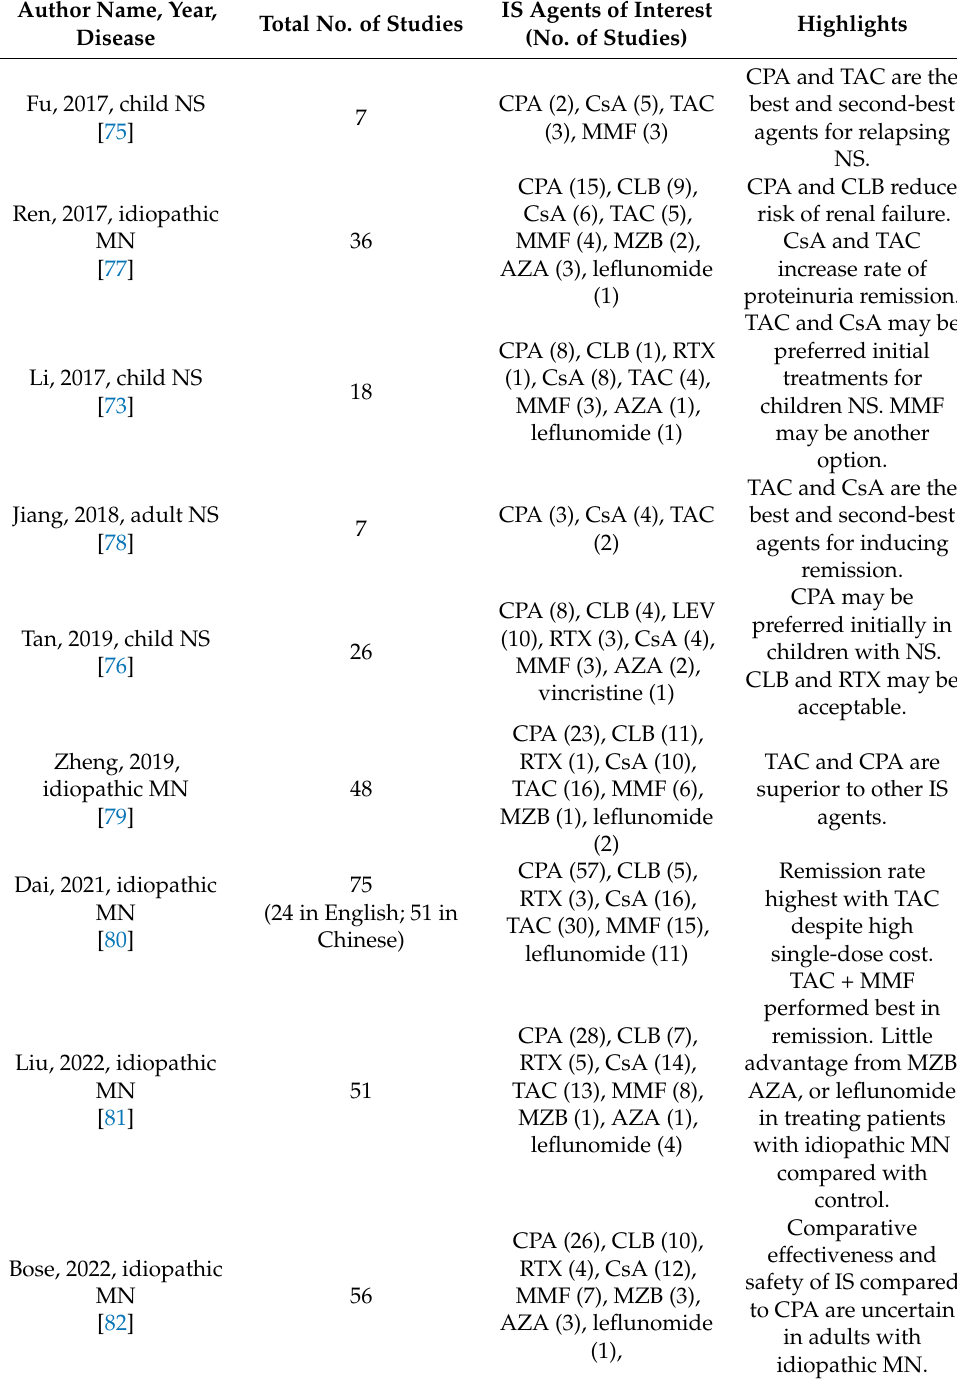
Table 2. List of network meta-analyses for NS regarding use of immunosuppressive agents mostly combined with